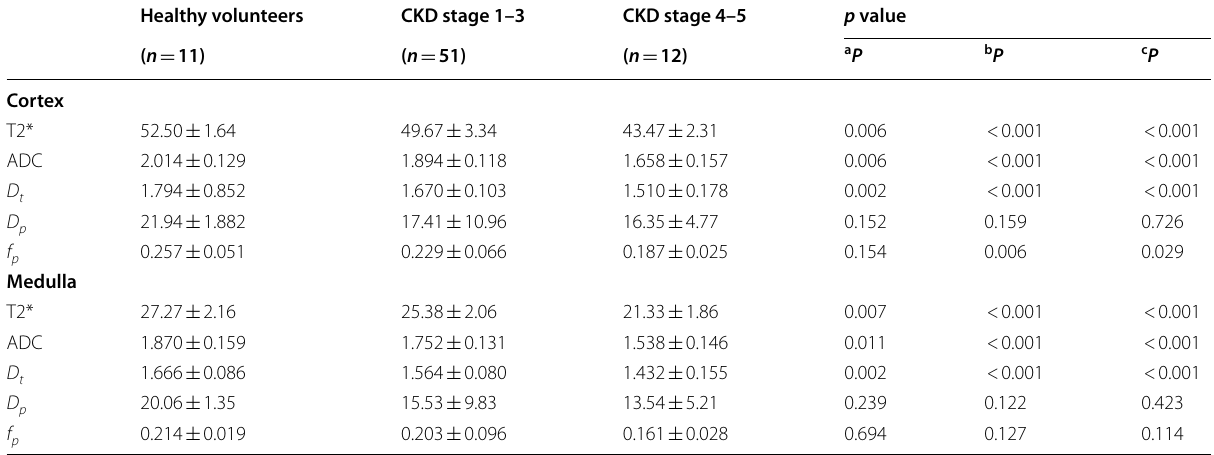
The unit of T2* is ms; ADC, D t and D p value are given as